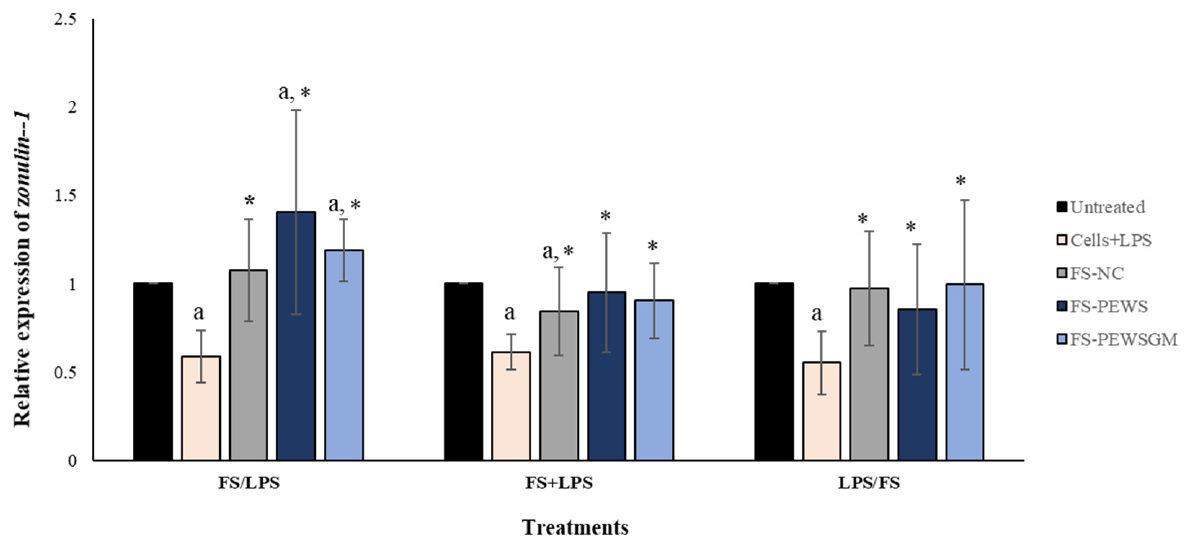
Figure 2. The effects of FSs from P. eryngii mushrooms (FS-PEWS and FS-PEWSGM) on zonulin-1 expression levels in LPS-induced Caco-2 cells. Caco-2 cells were subjected to LPS and FS treatment under three different conditions: pre incubation (FS/LPS), co-incubation (FS + LPS) and post-incubation (LPS/FS). Untreated: Caco-2 cells without any effect; FS-NC: FS of the negative control (NC: sample without additional carbon source); Cells + LPS: Caco-2 cells subjected to LPS (100 ng/mL). Data are expressed as mRNA expression (normalized with b-actin ) relative to untreated cells as mean ± SD of two independent experiments. a statistically significant for FS-PEWS or FS-PEWSGM compared to untreated cells ( p < 0.05), * statistically significant for FS-PEWS or FS-PEWSGM compared to Cells + LPS ( p < 0.05) (Wilcoxon matched-pairs signed rank test or paired samples t -test).